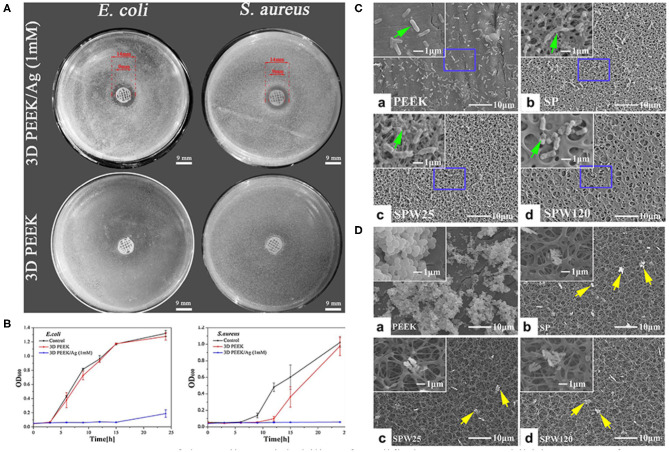
Assessment of the antibacterial ability of modified PEEK. (A) Inhibition zones of 3D PEEK and 3D PEEK/Ag against E. coli and S. aureus. (B) Bacterial dynamic curves of E. coli and S. aureus on 3D PEEK and 3D PEEK/Ag at OD600. Reproduced from Deng et al. (2017). Copyright (2017), with permission from Elsevier. (C)
E. coli and (D)
S. aureus seeded on the PEEK, SP (sulfonated only), SPW25 (sulfonated and hydrothermal treated at 25°C), and SPW120 (sulfonated and hydrothermal treated at 120°C) at a bacteria concentration of 107 cfu/ml. The green arrows indicate the morphology of E. coli (high magnification), while the yellow arrows show the morphology of S. aureus (low magnification). Reproduced from Ouyang et al. (2016). Copyright (2016), with permission from Elsevier.